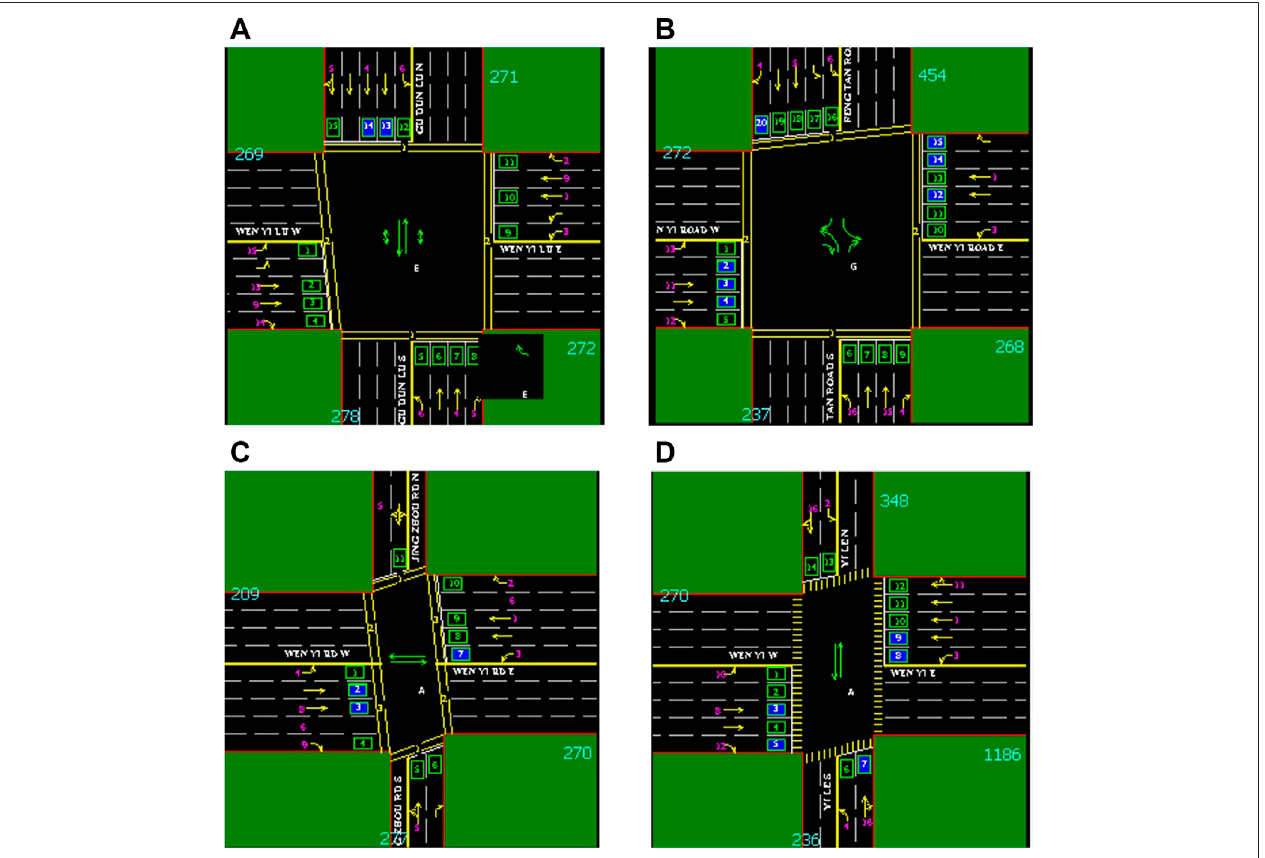
FIGURE3| Channelizationdiagramoffourintersections onWenyiRoad. (A) ChannelizationmapoftheGudunintersection. (B) ChannelizationmapoftheFengtan intersection. (C) Channelization map of the Jingzhou intersection. (D) Channelization map of the Yile intersection. Wenyi Road is an east – west road; there are four crossroads on this road: from west to east are Gudun Road, Fengtan Road, Yile Road, and Jingzhou Road.